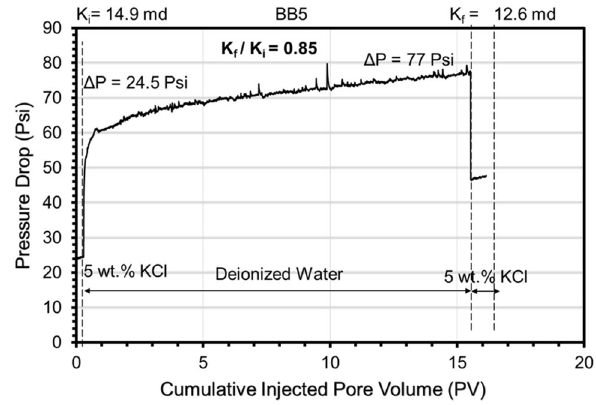
Fig. 5 Pressure drop across the sample Bandera Brown (BB5) as the deionized water injected at 5 cm 3 /min (backpressure = 1000 psi, con- fining pressure = 1700 psi)